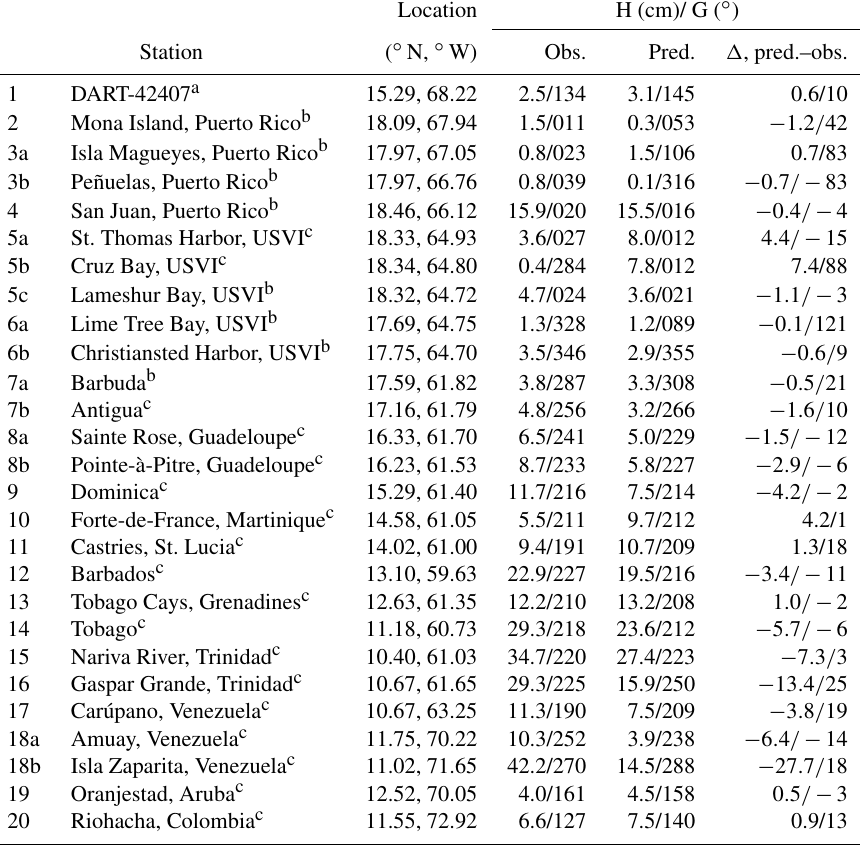
Table A1. Tide gauge stations and tidal statistics: M 2